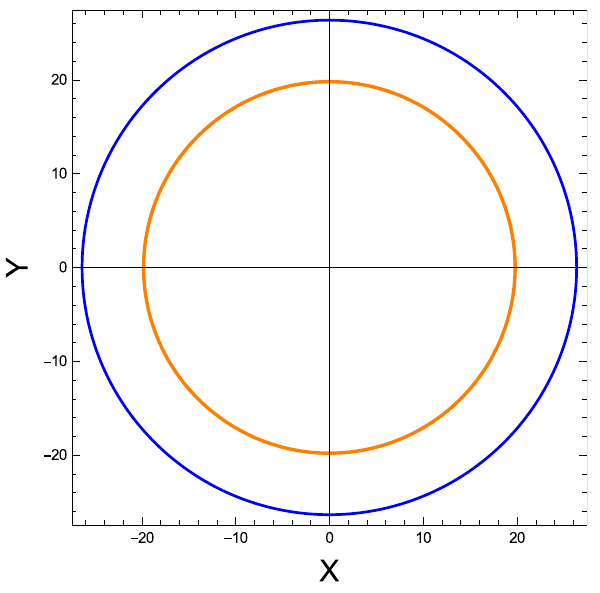
Fig. 8 The outermost relativistic Einstein ring as seen in the observers sky. The blue ring corresponds for Sgr A* and orange for the M87* Using the deflection angle Eq. (31), Eq. (38) reduces to ¯ aD (cid:16)α = − n